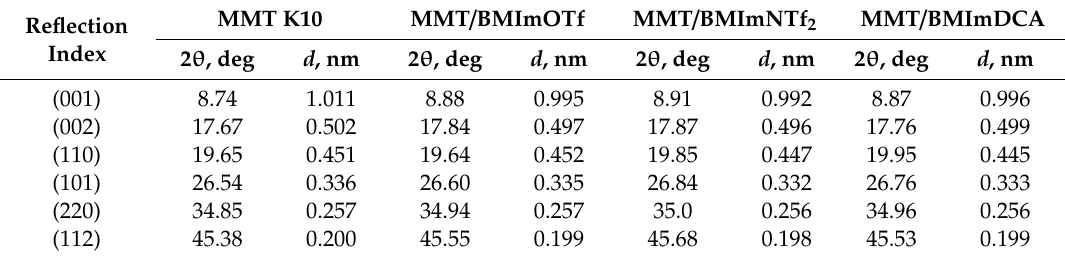
Table 1. Results of X-ray spectral analysis for MMT K10 and MMT K10/IL composites.